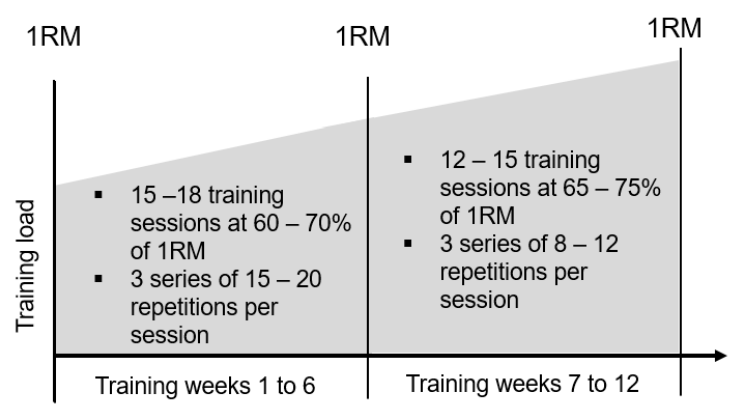
Figure 3. Study Figure 3. Study design.